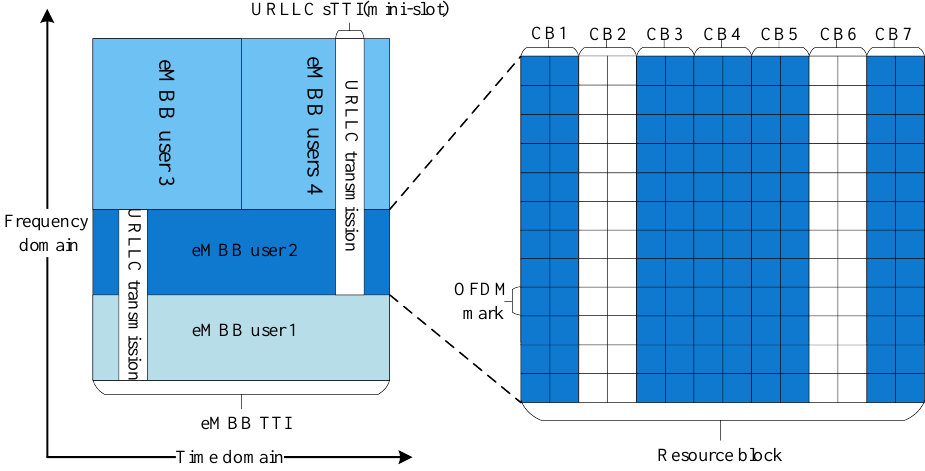
Figure 2. Multiplexing Model for eMBB-URLLC